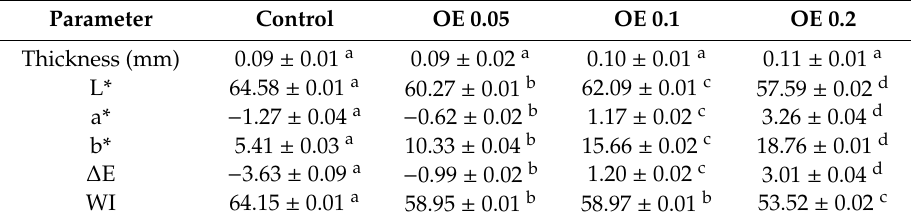
Di ff erent superscripts ( a,b,c,d ) within the same row and parameter indicate statistically significant di ff erent values ( p < 0.05); OE indicates olive